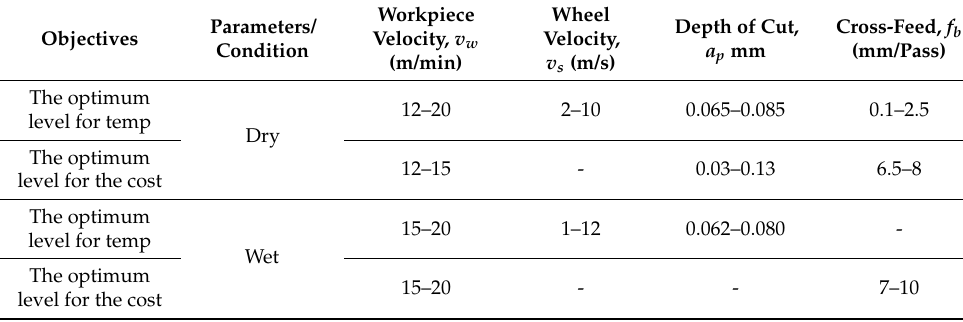
Figure 6. Contour plot of the temperature for each combination of input parameters. ( a ) Surface grinding under dry condition and ( b ) surface grinding under wet condition. Table 5. Optimum range of input parameters from